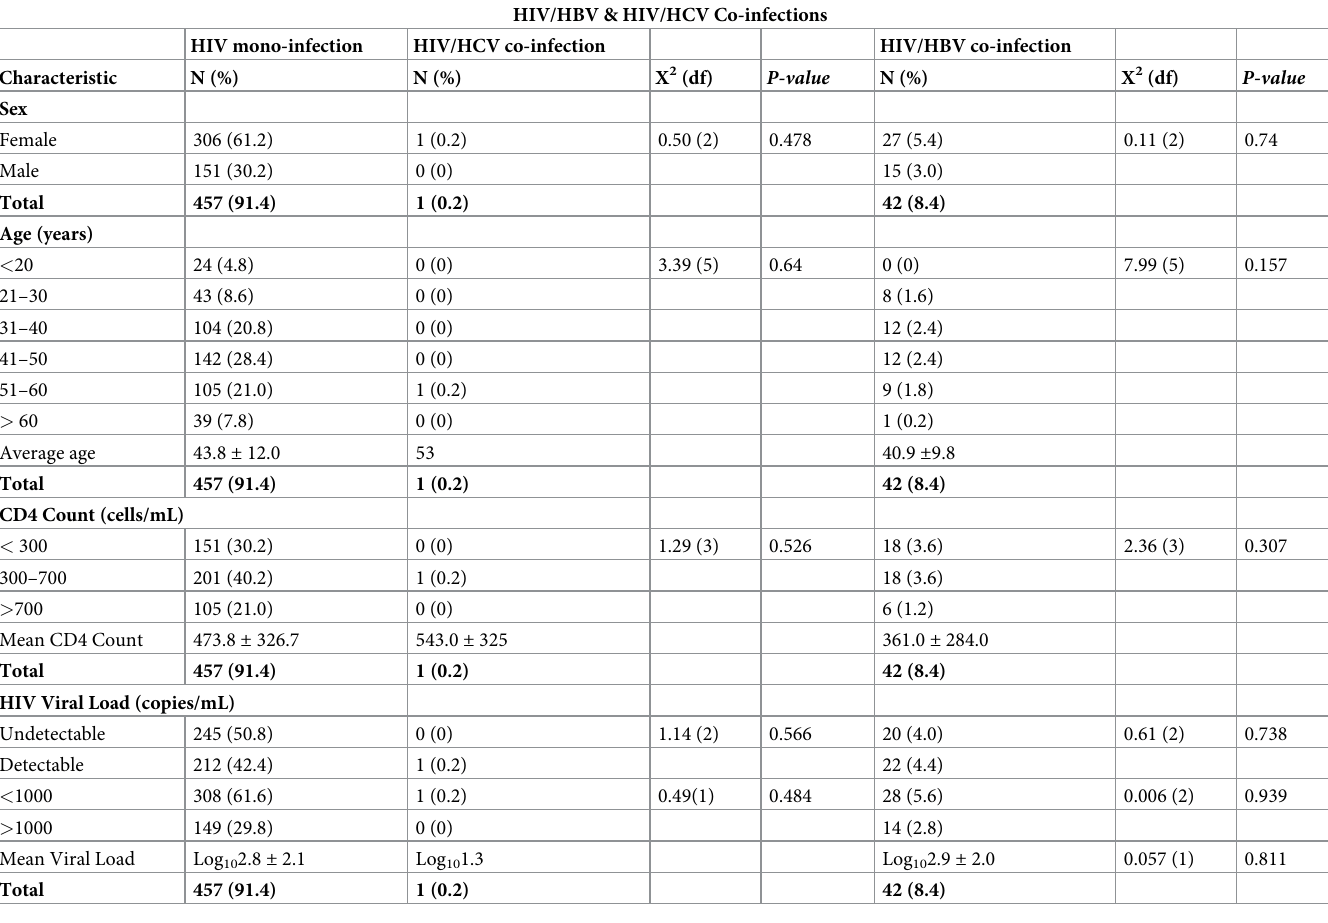
Table 4. Effect of HBV and HCV co-infection on serologic and virologic